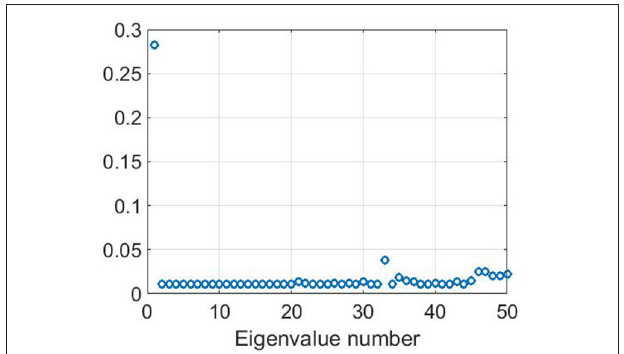
FIGURE 2 | Plot of adaptively chosen ε for two-moon dataset. The values of